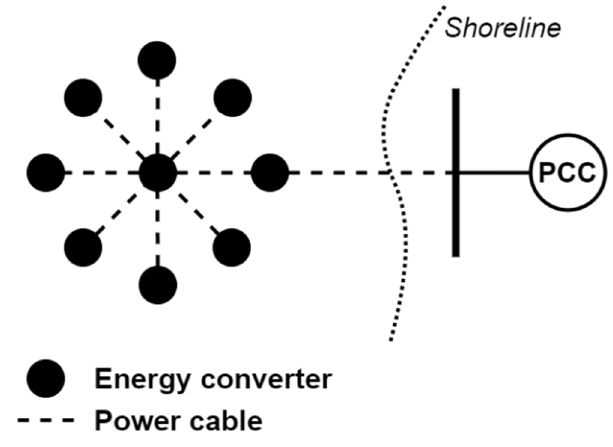
Figure 4. Star topology.